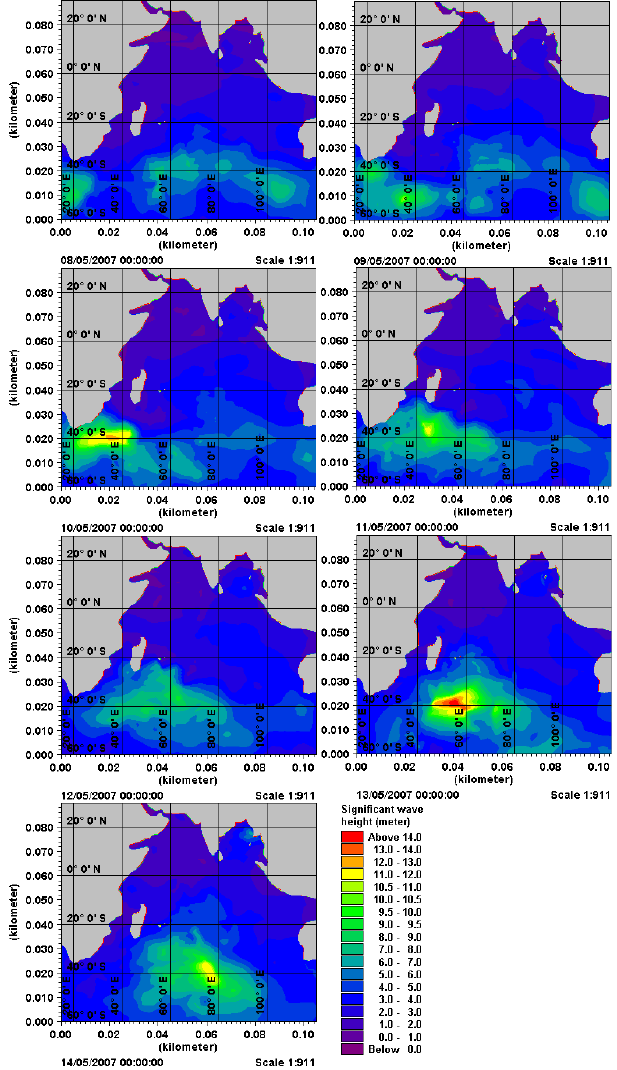
Fig. 6. Propagation of swells during May 2007 in the north Indian Ocean (altimeter